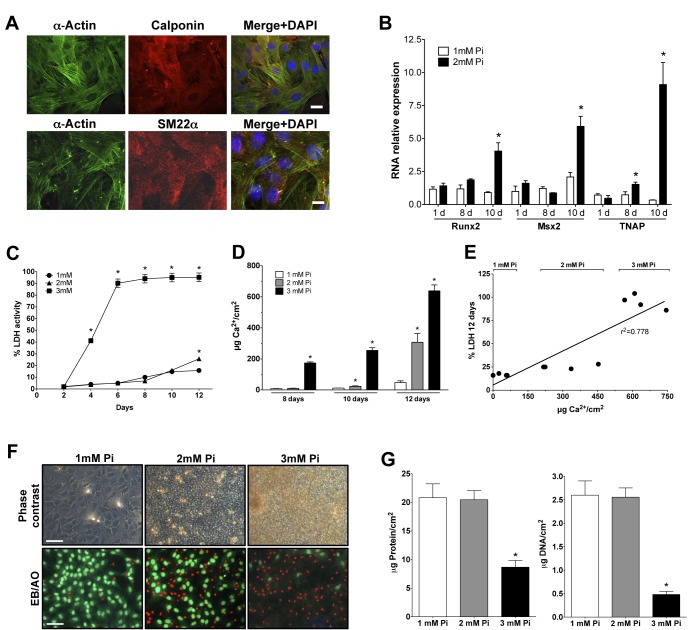
Cell death during in vitro calcification.(A) Microphotographs of rat VSMC at passage 3, immunodecorated with smooth muscle markers. Bar, 20μm. (B) Osteogene RNA expression in VSMC cultured in MEM containing 1 or 2mM Pi for 1, 8, or 10 days. ANOVA p < 0.0001 for all three genes. *Significantly different from the corresponding 1mM Pi with Tukey’s and a t-test. (C) LDH activity, as a percentage of day 0, in VSMC incubated using Pi concentrations for up to 12 days in MEM. ANOVA p < 0.0001, *Different from the corresponding 1mM Pi with Tukey’s test. At 12 days, the difference at 2 and 1mM Pi is also significant with a t-test (p < 0.0001). (D) Calcium deposition at days 8, 10, and 12. ANOVA, p < 0.0001; *Different from the corresponding 1mM Pi with Tukey’s test. (E) Calcium deposition and LDH activity correlation after 12 days of calcification in vitro. (F) Phase contrast and EB/AO staining microphotographs after 12 days. Bar, 50μm. (G) VSMC, total protein (ANOVA, p < 0.005), and DNA content (ANOVA p < 0.005) after 12 days of Pi treatments; *Different from 1mM with Tukey’s test.